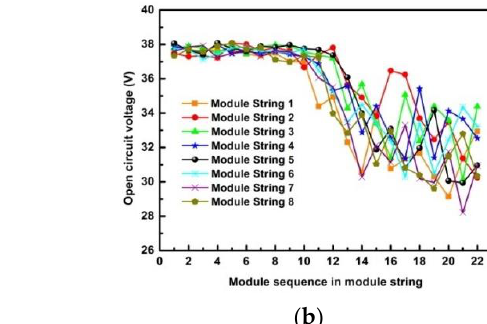
Figure 5. The relationship between the voltages of solar modules under open circuit and module sequence in PID-affected monocrystalline silicon module string ( a ) and multicrystalline silicon module string ( b ). The values of open circuit voltage were measured in the field and translated to STC.